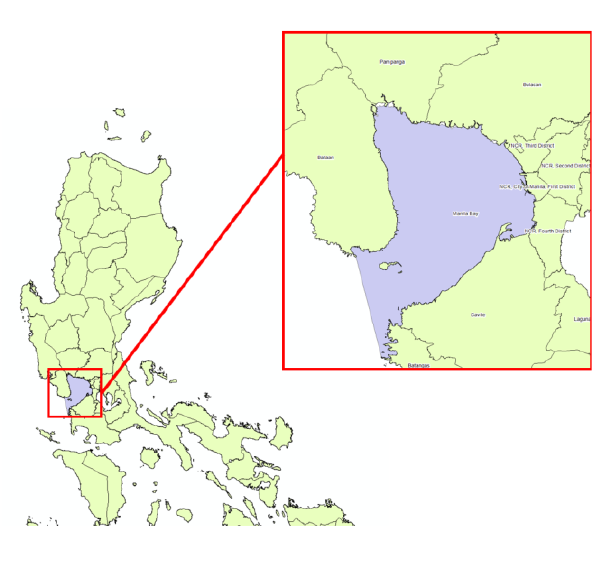
Figure 4 . Manila Bay Area